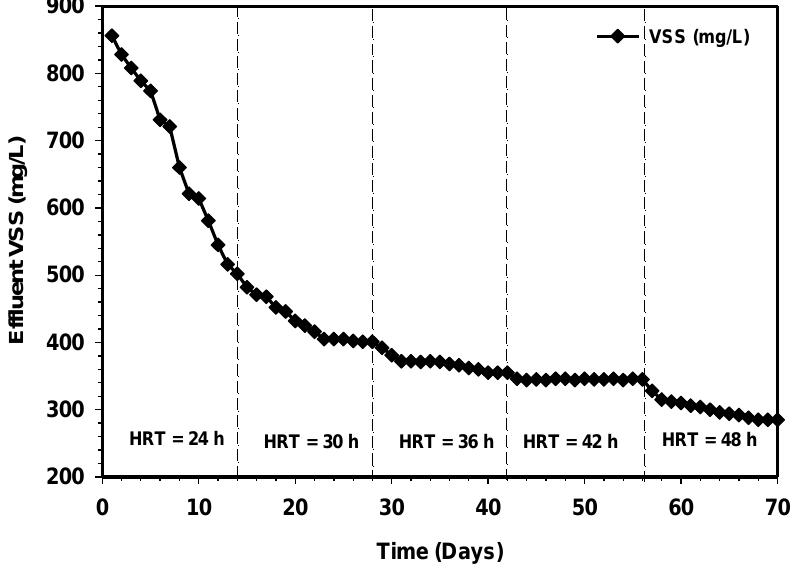
Figure 7. Variation of VSS removals relative to increasing contact time.